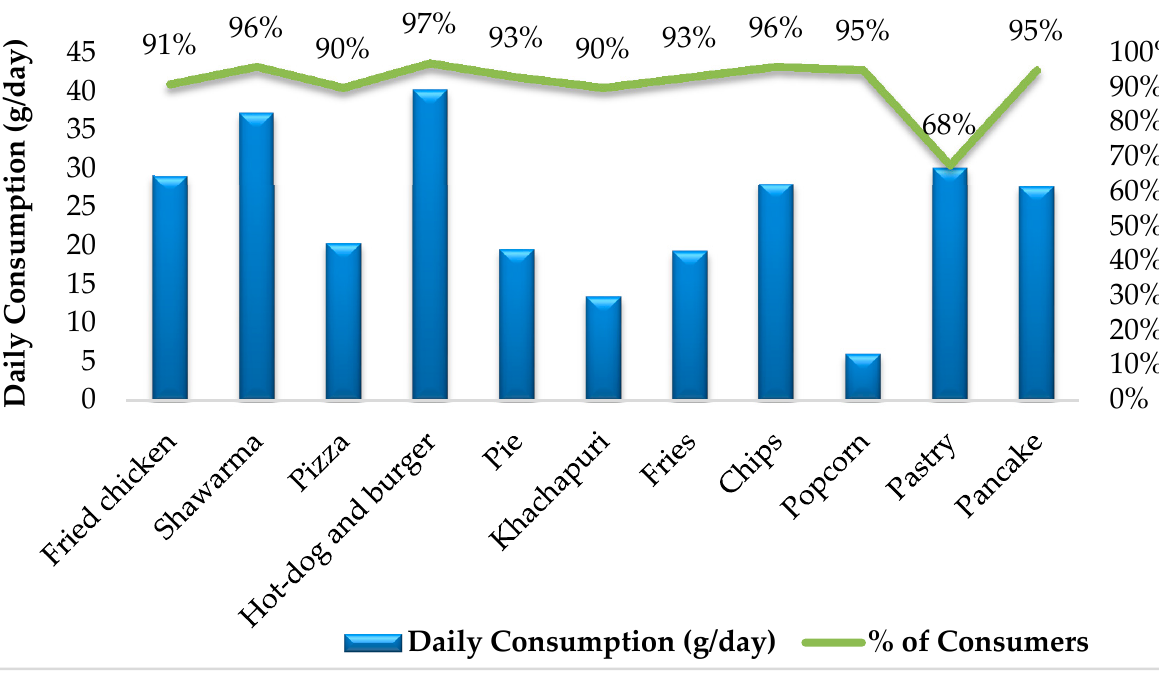
Figure 2. Average Daily Consumption of Fast-Food (g/day).